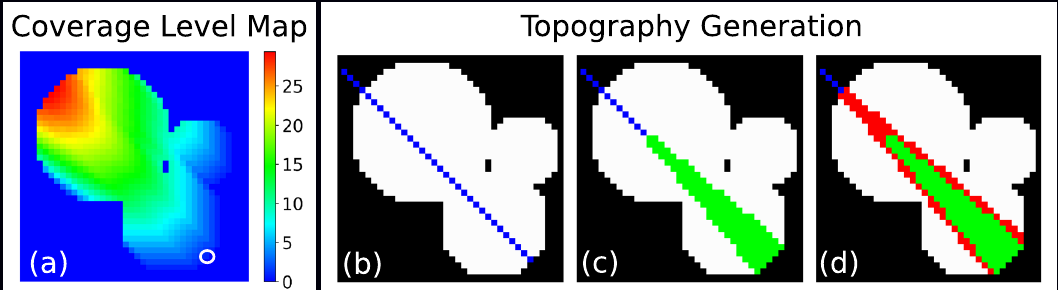
Figure 2. Coverage level map for the South-East SDD ( a ), showing the amount of sample in µm present between each pixel and the detector’s center. A first seed pixel, with minimal sample coverage (white circle) is picked. Other seed pixels are identified along the line (blue) connecting the SDD’s center with this first seed ( b ). The reconstruction process initializes through a first conical region of interest ( c ), which is resolved and fixed before moving onto the next region ( d